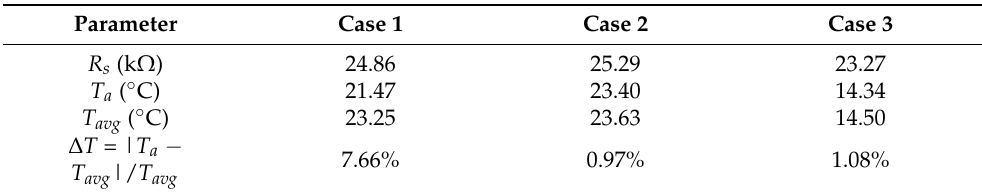
Table 4. The measured series resistances ( R s ), calculated mean temperatures ( T a ) and measured average temperatures ( T avg ).